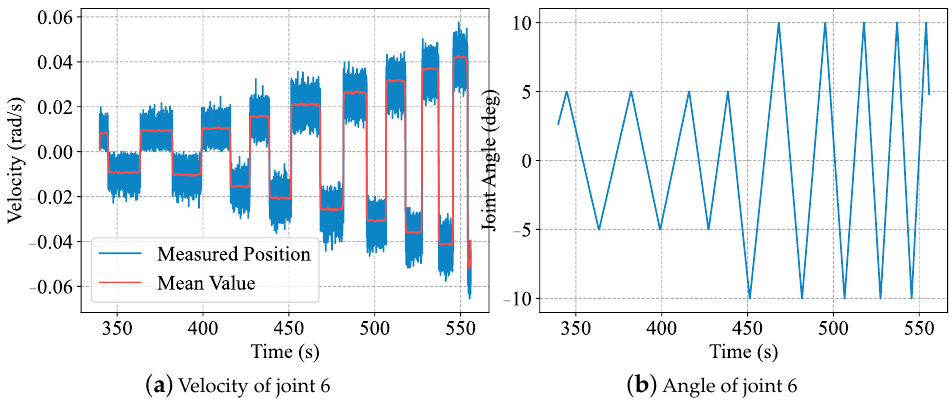
Figure 5. This figure shows the measured data of the sixth joint. For clarity, the figure shows the duration of data acquisition is 216.023 s, starting at 339.765 s and ending at 555.788 s. ( a ) Measured velocity (blue line) from the servo driver is noisy, so median filtering (red line) is required. ( b ) Mea- sured position from the servo driver. The limitation angle is ± 5 ◦ when | ˙ q | < 0.02 rad/s, and the limitation angle is ± 10 ◦ when | ˙ q | ≥ 0.02 rad/s.